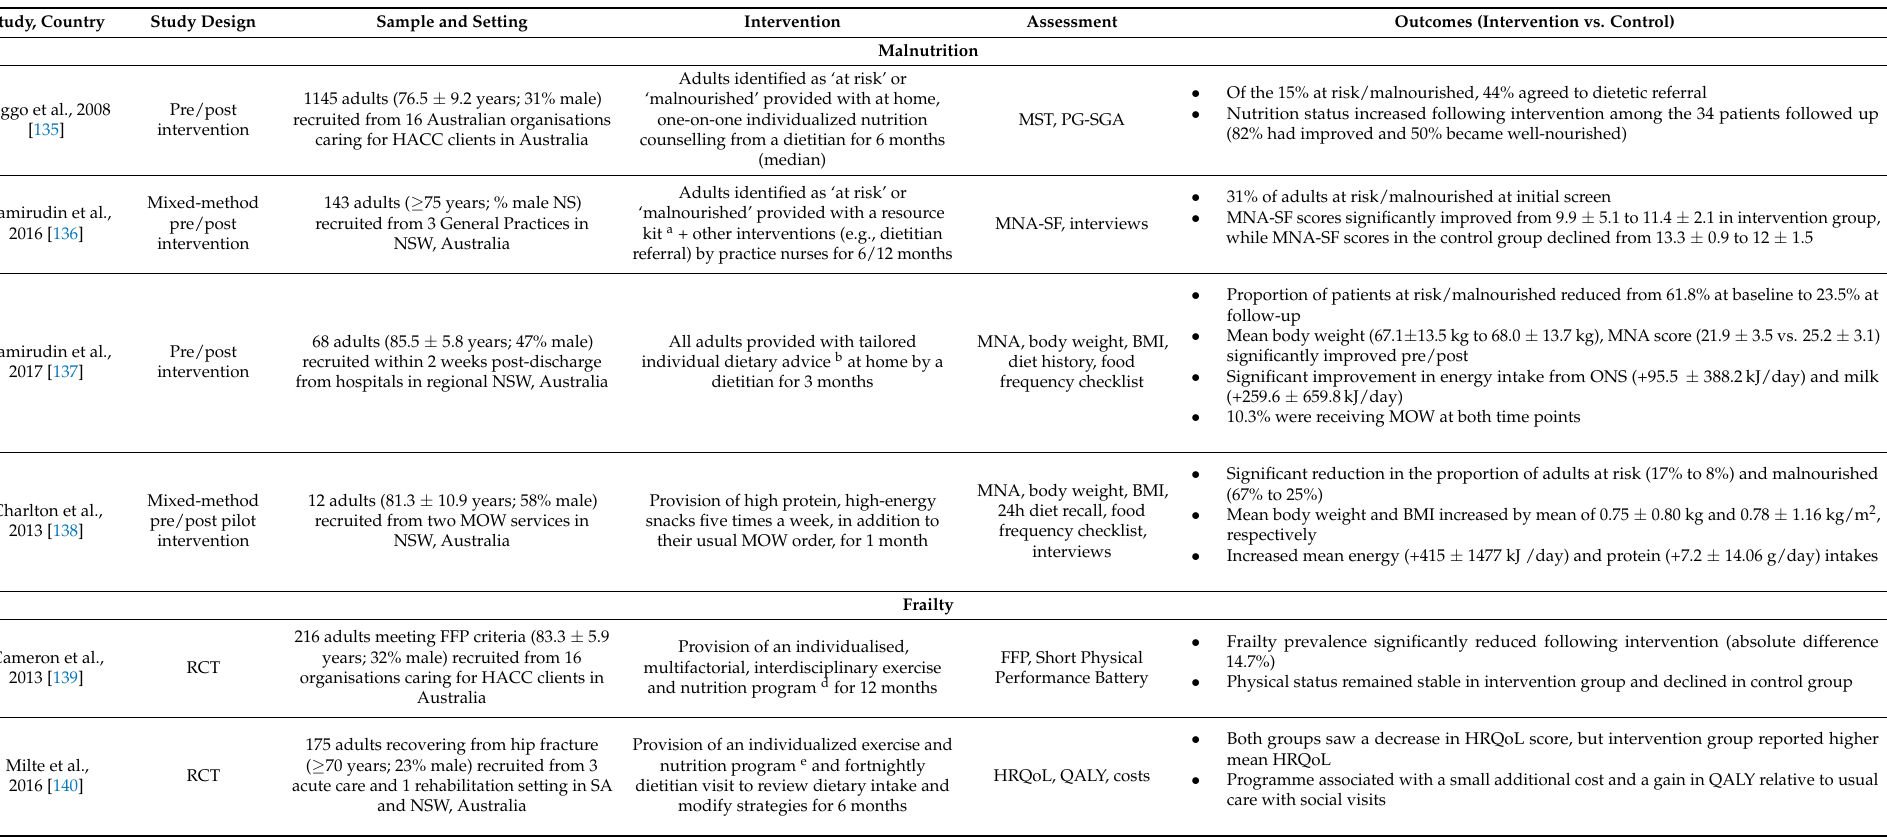
Table 4. Summary of nutrition-related intervention studies targeting malnutrition, frailty or sarcopenia among community dwelling older ANZ adults